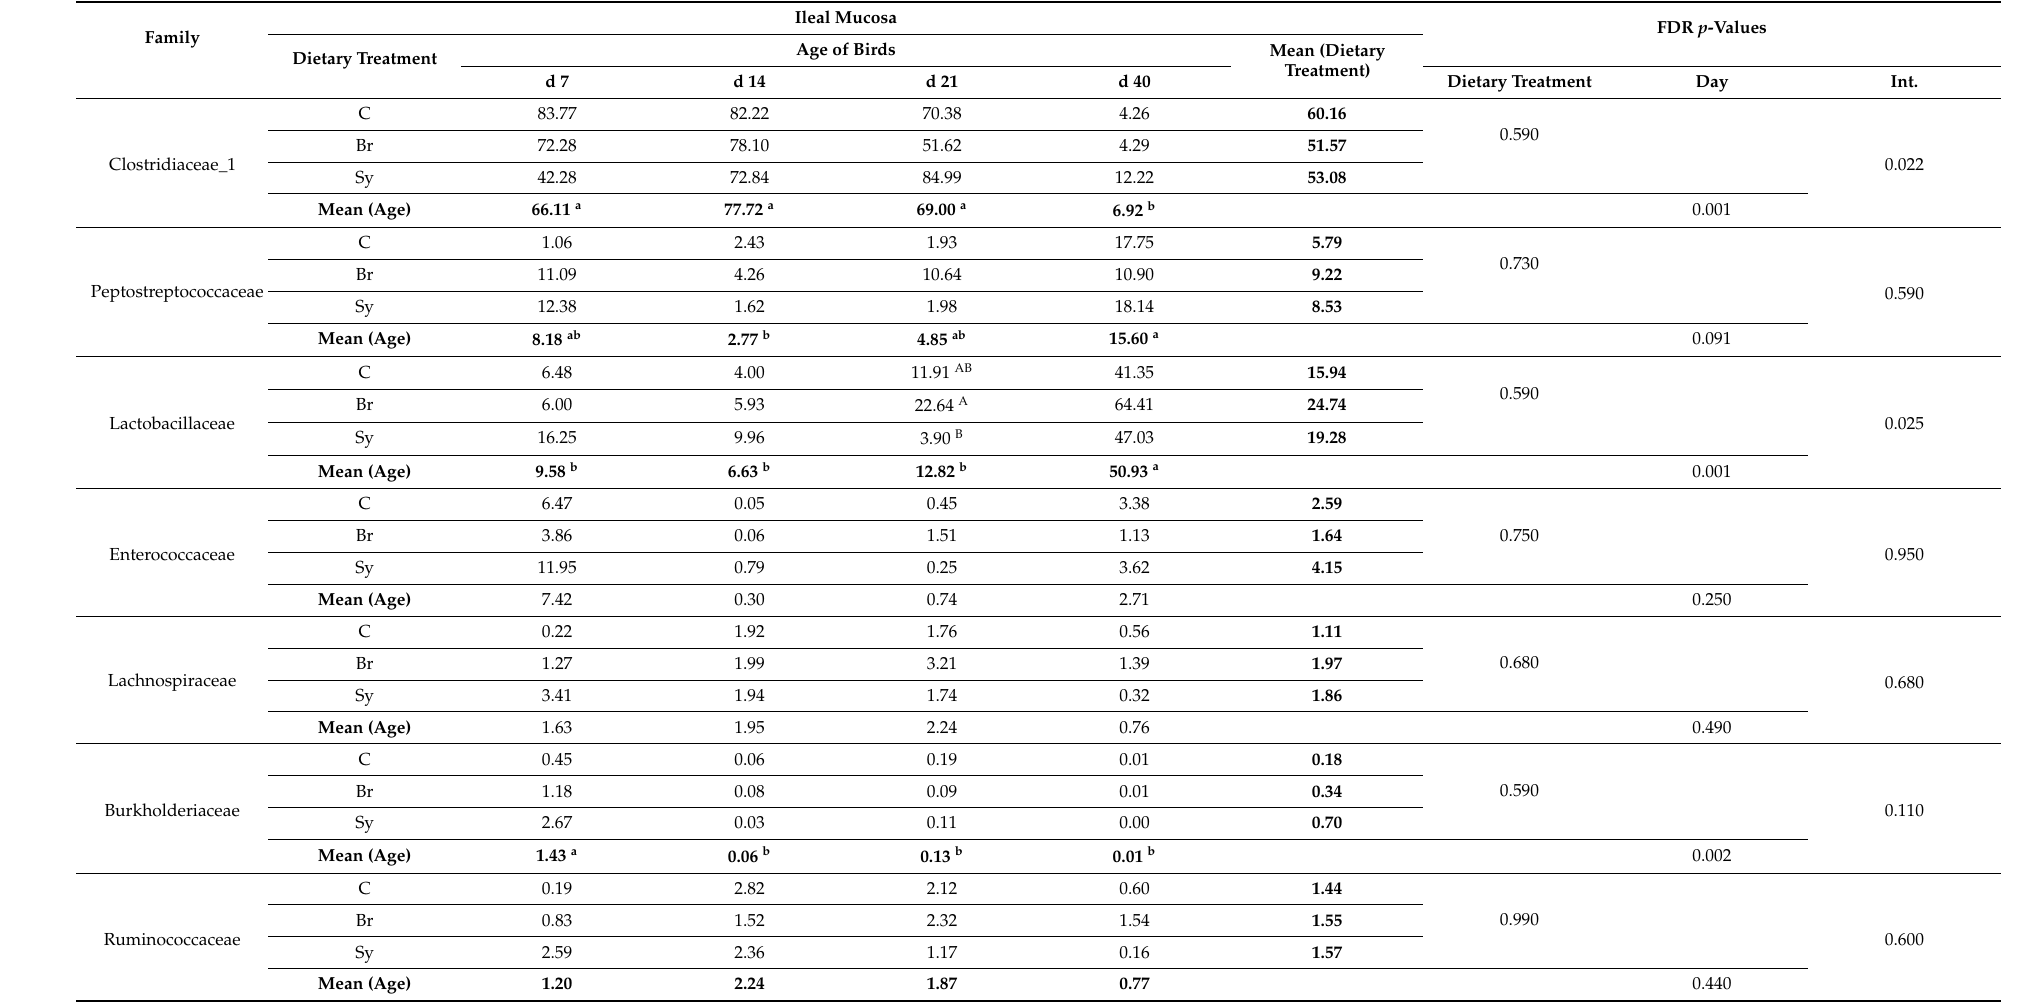
Table 4. Relative abundance of bacterial families in the ileal mucosa of broiler chickens as affected by dietary treatments and age (%). Ileal Mucosa FDR p -Values Family Dietary Treatment Age of Birds Mean (Dietary Treatment) d 7 d 14 d 21 d 40 Dietary Treatment Day